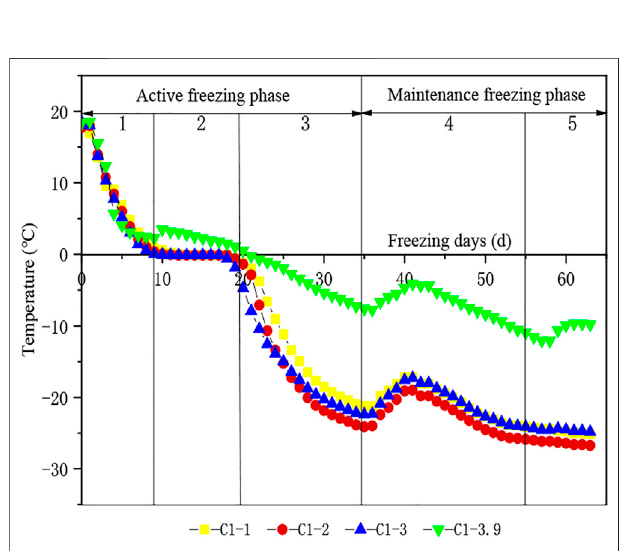
FIGURE8| CorrelationbetweenthetemperatureintemperatureholeC1 and time.